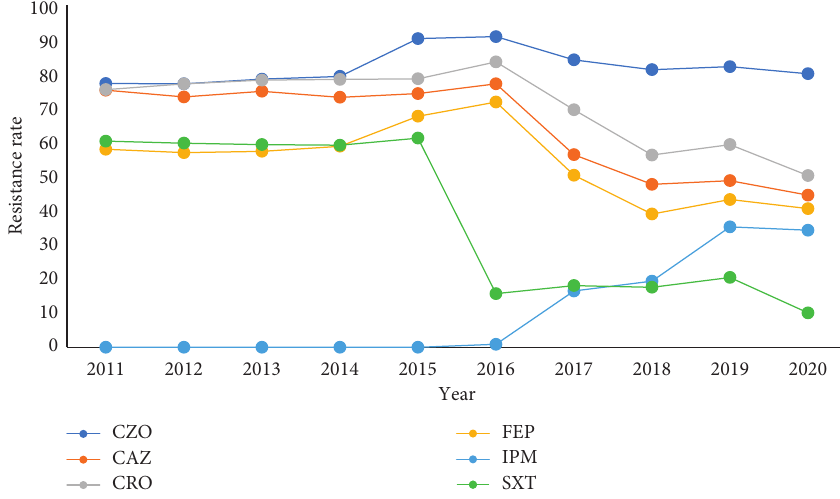
Figure 22: Changes in drug resistance of K. pneumoniae from 2011 to 2020